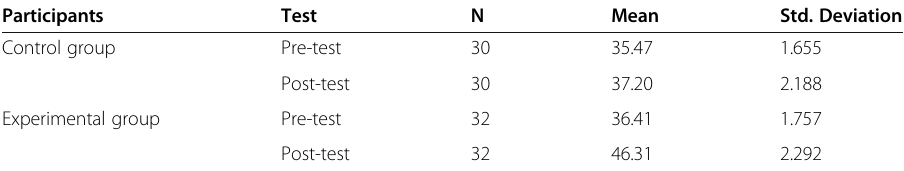
Table 1 Descriptive Statistics of Control and Experimental Groups Participants